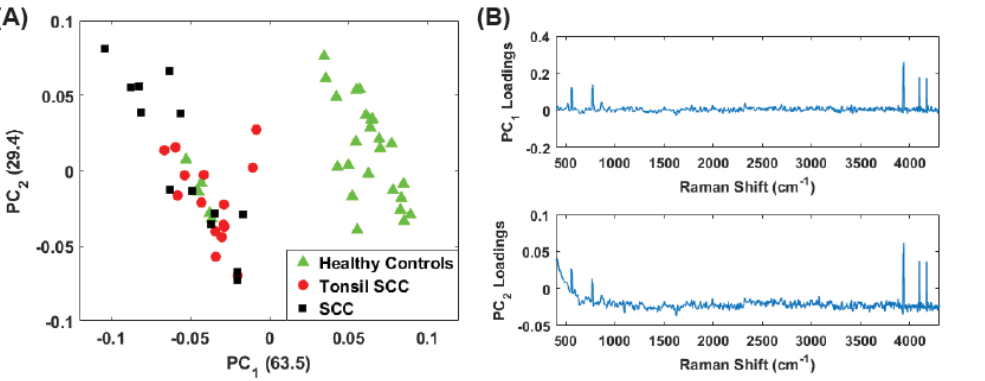
Figure 9. ( A ) Plot of the first two PC scores for only the unstained tissue samples. The analysis was performed in the Raman shift region from 400 cm − 1 –4300 cm − 1 and show good separation between the healthy and diseased tissue classes. The numbers in parentheses represent the information content associated with each principal component. ( B ) Corresponding loadings plots for the PCs shown in ( A ).